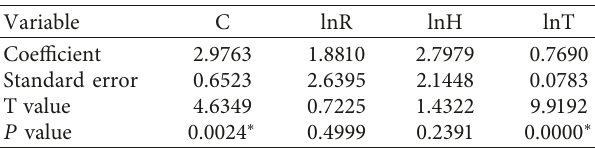
Table 2: Analysis